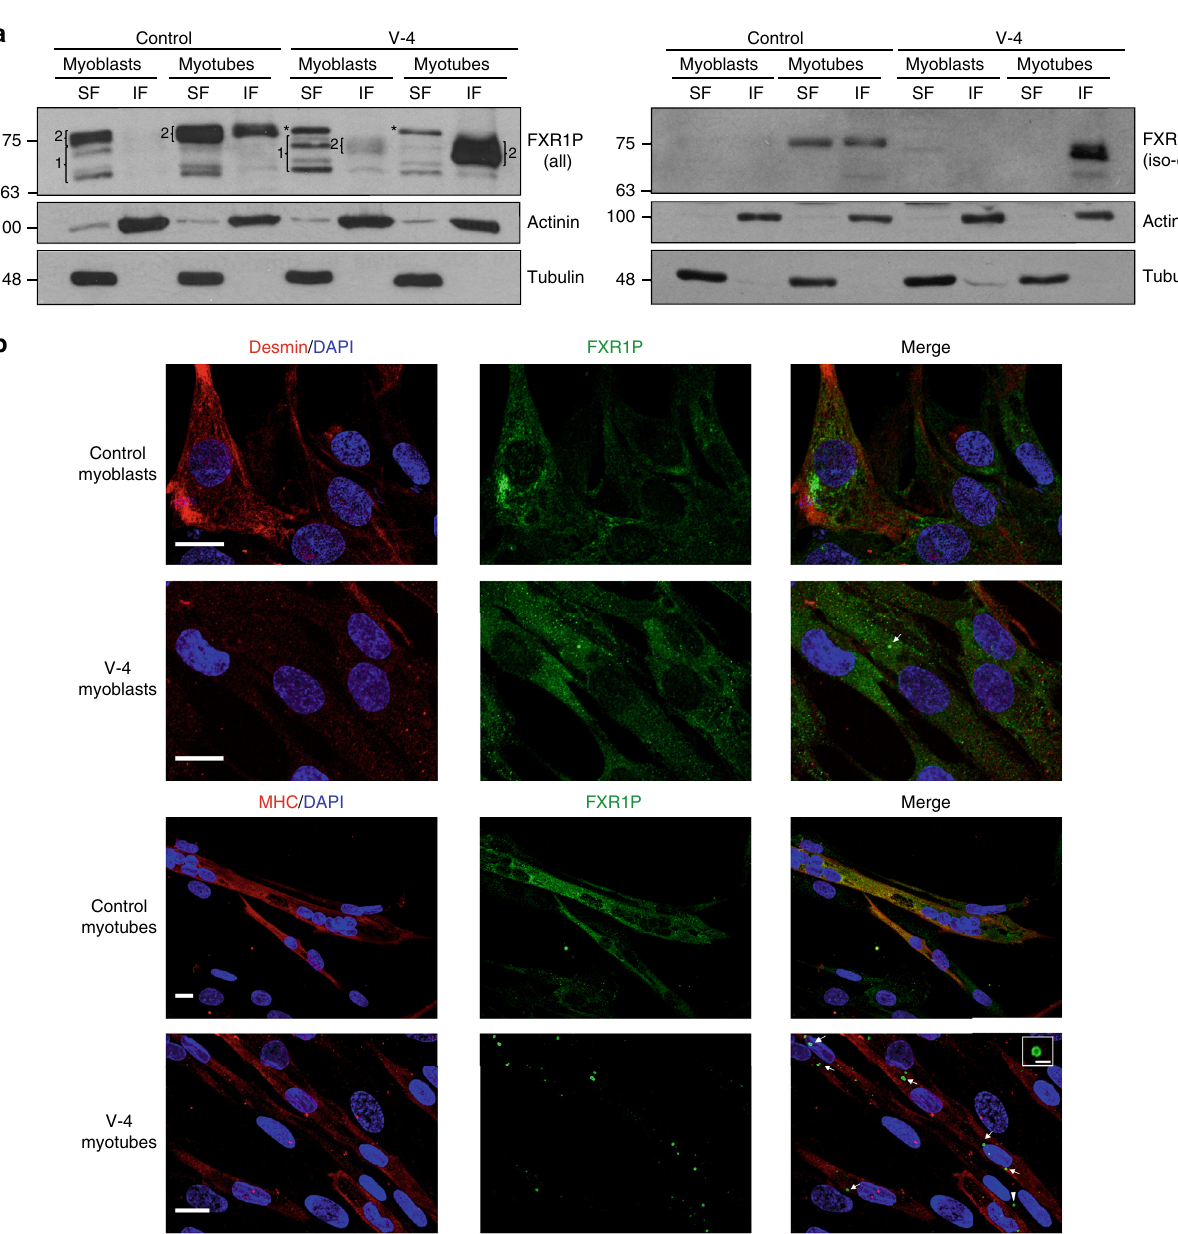
Fig. 2 Expression and localization of FXR1P isoforms in family 1. a Representative anti-FXR1P immunoblots of soluble (SF) and insoluble (IF) fractions of protein extracts from control and V-4 myoblasts and myotubes, n = 5. An antibody against all FXR1P isoforms (Proteintech) and another one speci fi c for iso-e/f (#27-15) were used in left and right panels, respectively. Numbered brackets on left panel designate P70-80 FXR1P isoforms (1), and P82,84 isoforms (2). Asterisks indicate a non-speci fi c band. α -actinin and α -tubulin were used as loading controls. b Anti-FXR1P immuno fl uorescence showing subcellular distribution of FXR1P in control and V-4 myoblasts and myotubes, n = 5. Scale bar 15 µ m. Arrows in V-4 myoblasts and myotubes point to ring- shaped granular accumulations of mutant P82,84 isoforms. The granule magni fi ed in V-4 myotubes is indicated with an arrowhead (scale bar 2 µ m). Desmin and MHC were used as myogenic markers with MHC being an indicator of myotube differentiation. Nuclei are stained with